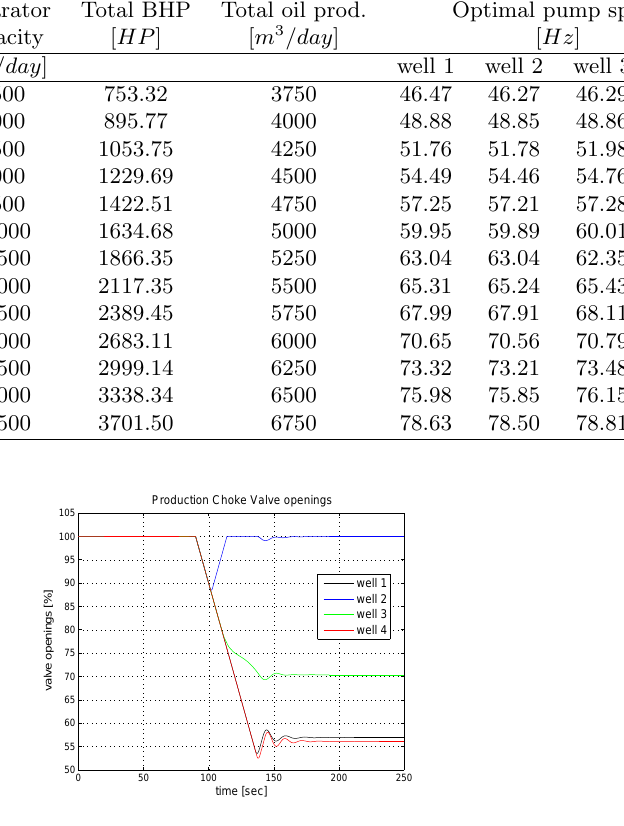
Figure 7: Operating window of ESPs for very lower separator